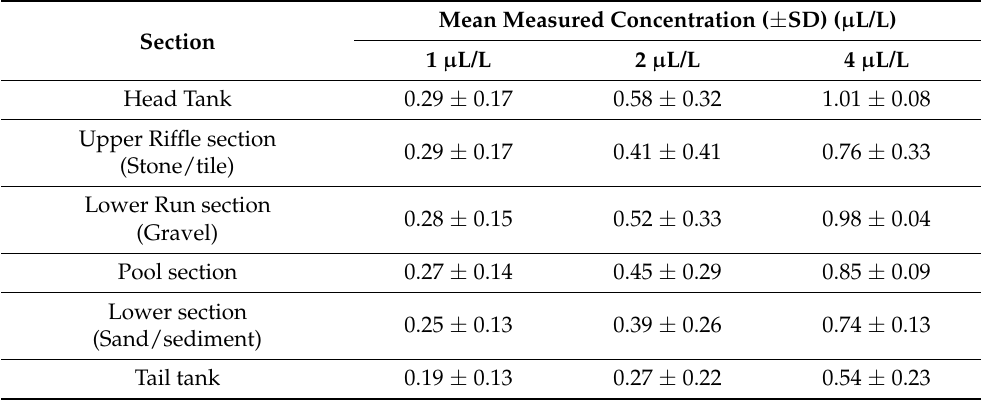
Table 4. Mean measured concentration of benzyl chloride in water in each section.